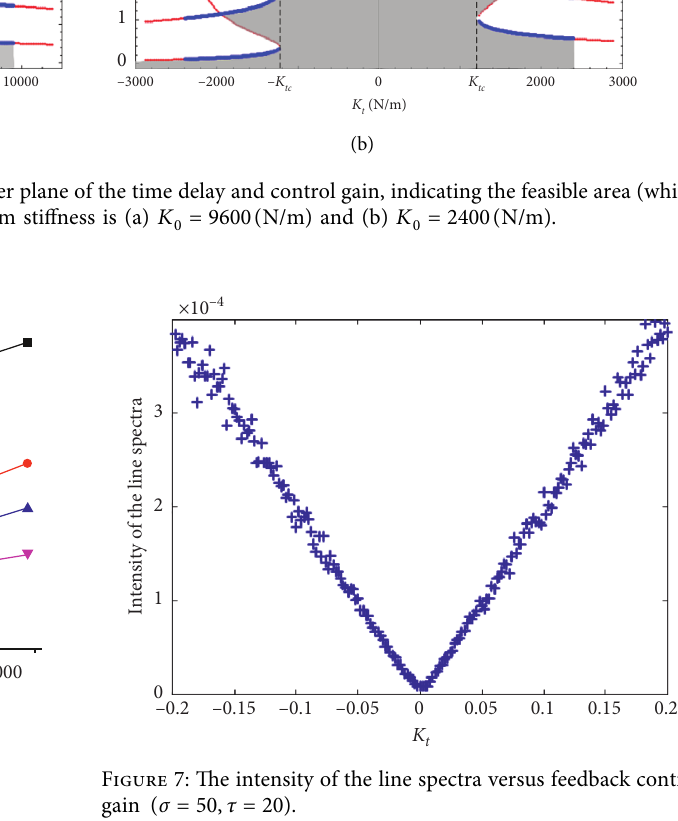
Figure 6: The critical control gain for chaotification versus dif- ferent equivalent linear stiffnesses for different damping ( C 1 and C 2 are the damping coefficients of the double-layer system, respectively).